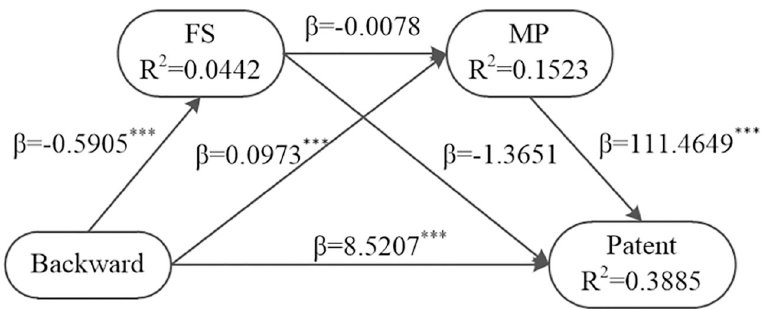
Fig 6. Chain intermediary test of financing structure and market power with backward integration.